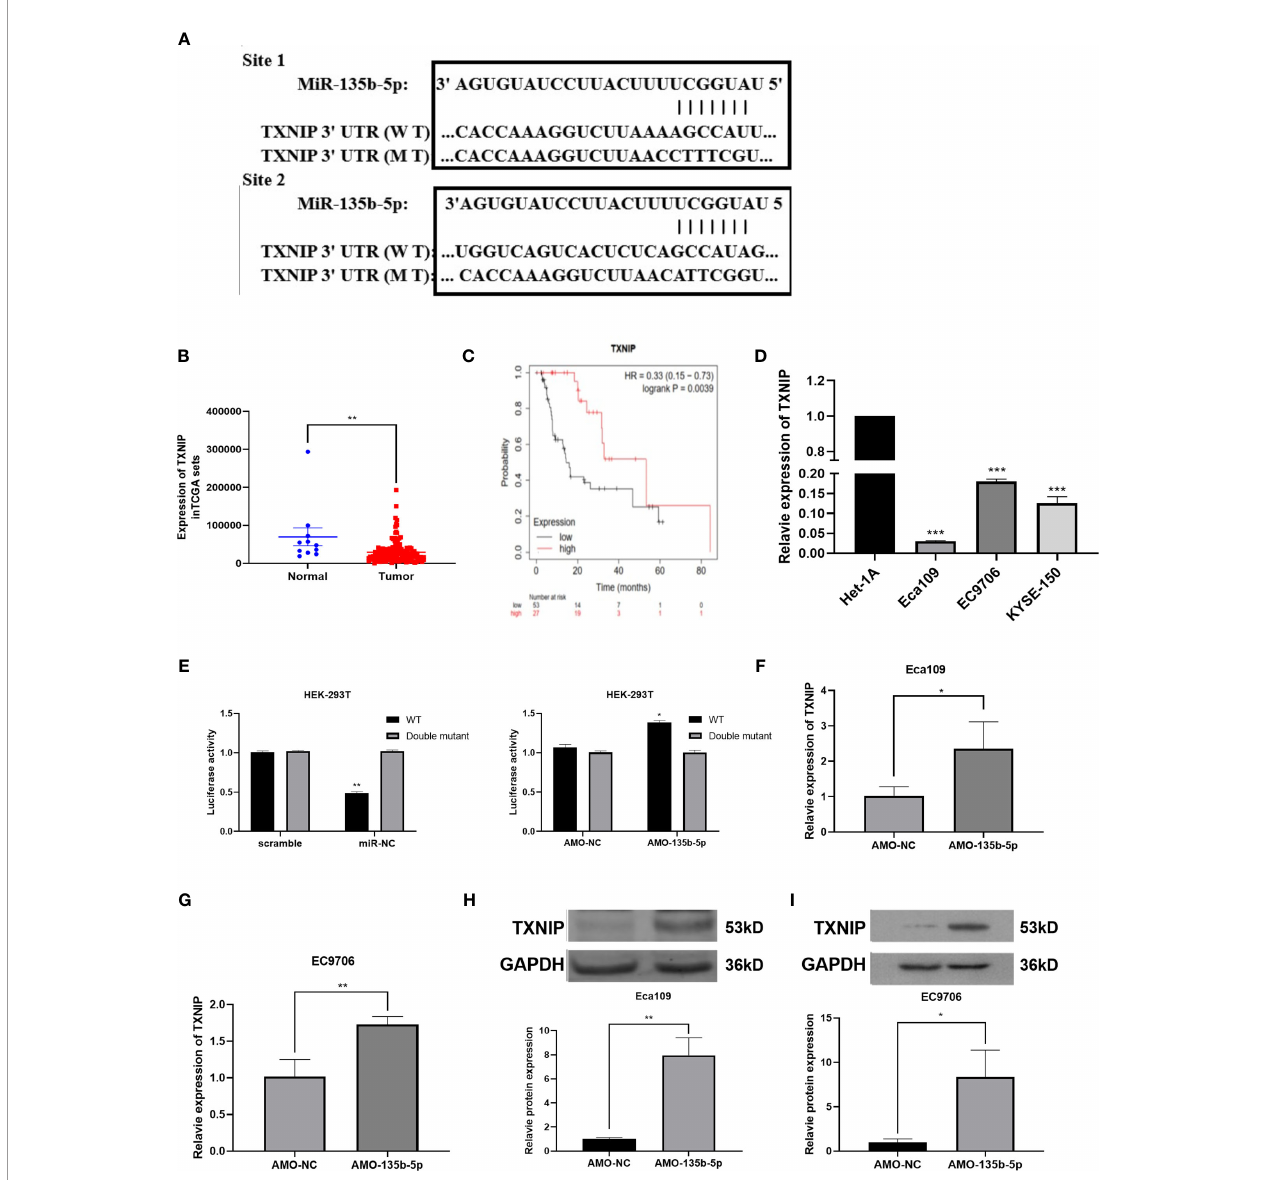
FIGURE 4 | TXNIP as a complementary gene of miR-135b-5p. (A) TargetScan tool anticipated miR-135b-5p has two complementary positions with the 3 ’ -UTR of TXNIP. (B) The expression of TXNIP in EC tissues. (C) KM plotter showed the relationship between TXNIP expression situation and the overall survival of EC patients. (D) TXNIP expression was signi fi cantly downregulated in Eca109, EC9706, KYSE150 cells than that in Het-1A cells. (E) Luciferase activities reporter assay analyzed the direct binding effect between miR-135b-5p and TXNIP. (F – l) Expression of TXNIP in with transfected AMO-135b-5p and AMO-NC, respectively (*p < 0.05, **p < 0.01, ***P <